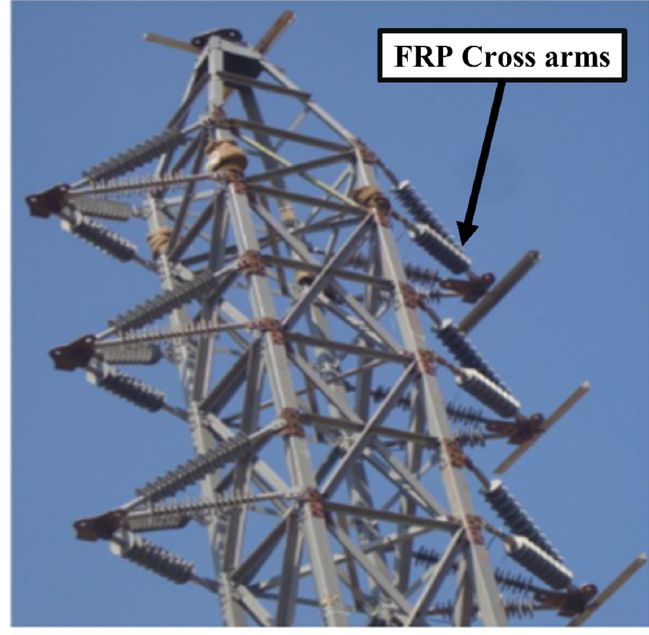
Figure 27. Photo of FRP cross ‐ arm on FRP tower body [83].